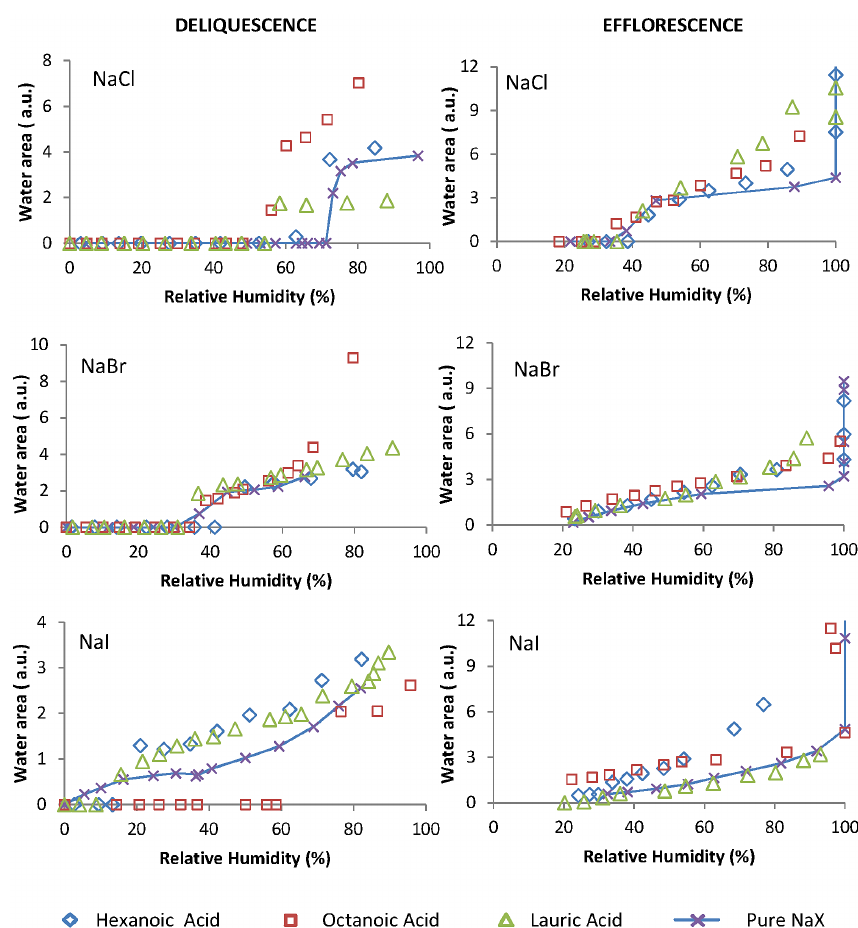
Figure 7. Deliquescence and efflorescence curves of NaX (X=Cl, Br, I) particles covered with HA, OA and LA. The curves for the pure inorganic salts are shown by lines. Left and right panels show deliquescence and efflorescence curves, respectively. Liquid-water mass is calculated as explained in Sect.